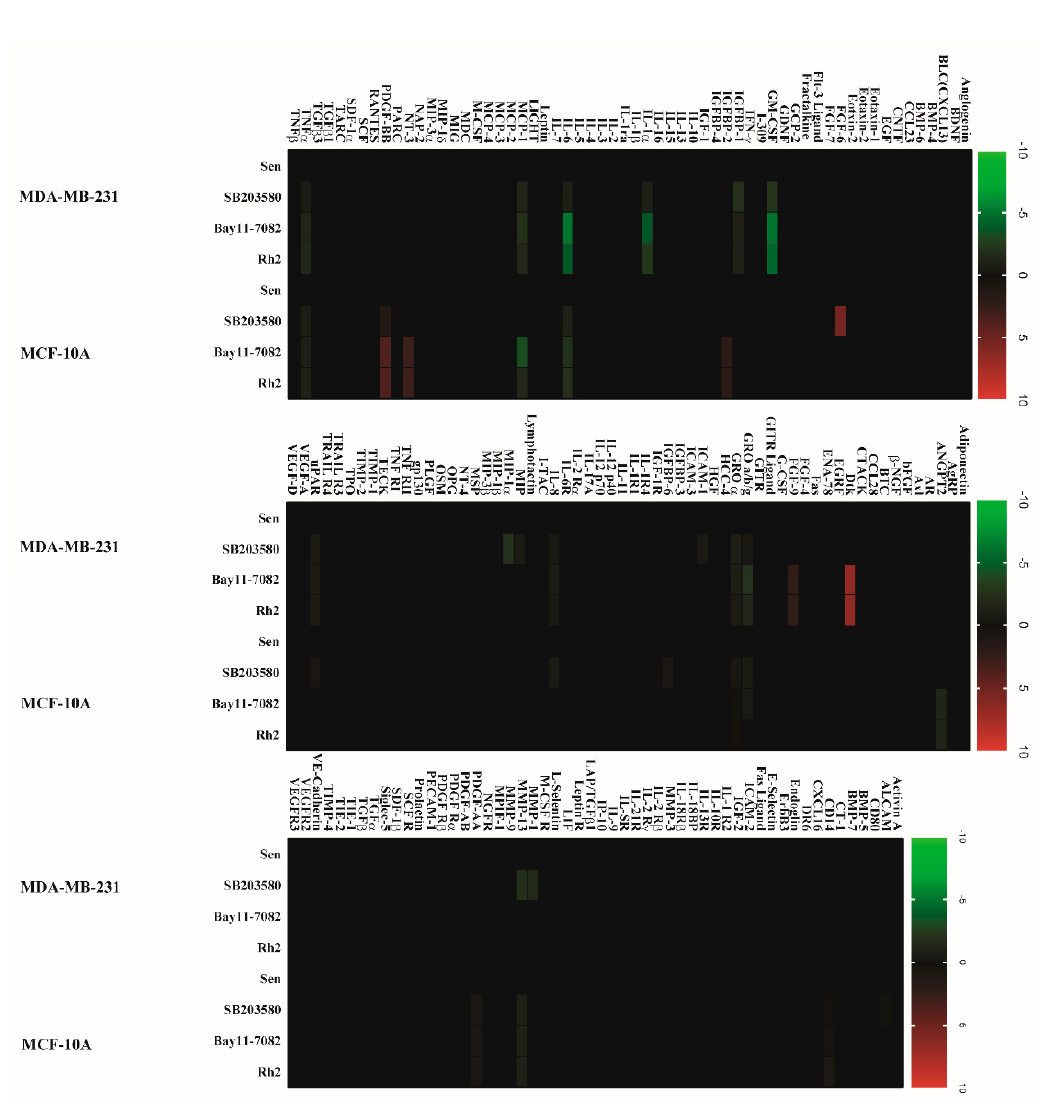
Figure 6. Rh2 suppressed SASP secretion in breast cell lines. Conditioned medium, prepared from senescent cells treated with DMSO, SB203580 (10 µ M), Bay11-7082 (10 µ M), and Rh2 (20 µ g/mL), was analyzed with human cytokine antibody arrays. Levels of each cytokine factor in untreated cells were arbitrary set to zero. Data shown represent log2-fold change in expression relative to untreated cells. Signals higher than the senescent control are shown in red; signals lower than the senescent control are shown in green.